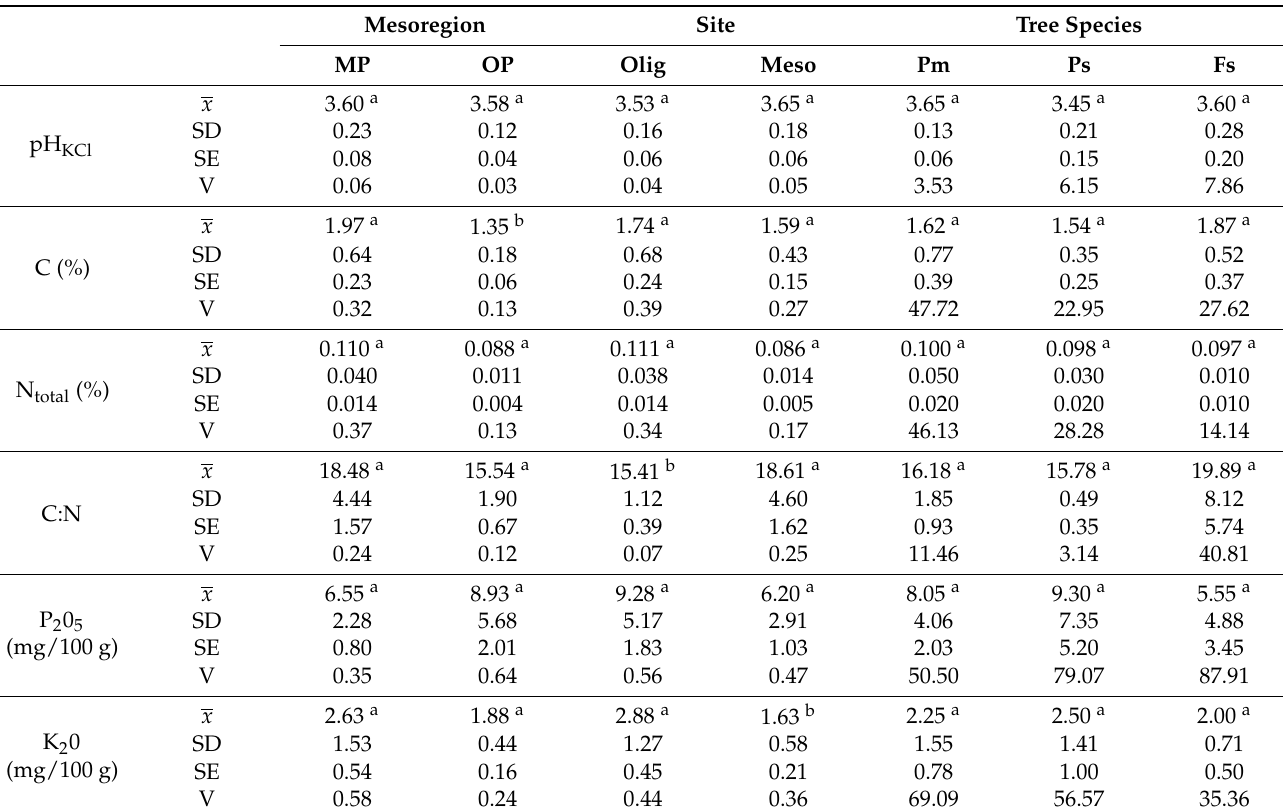
Table 3. Average values of analyzed soil properties in comparable variants and descriptive